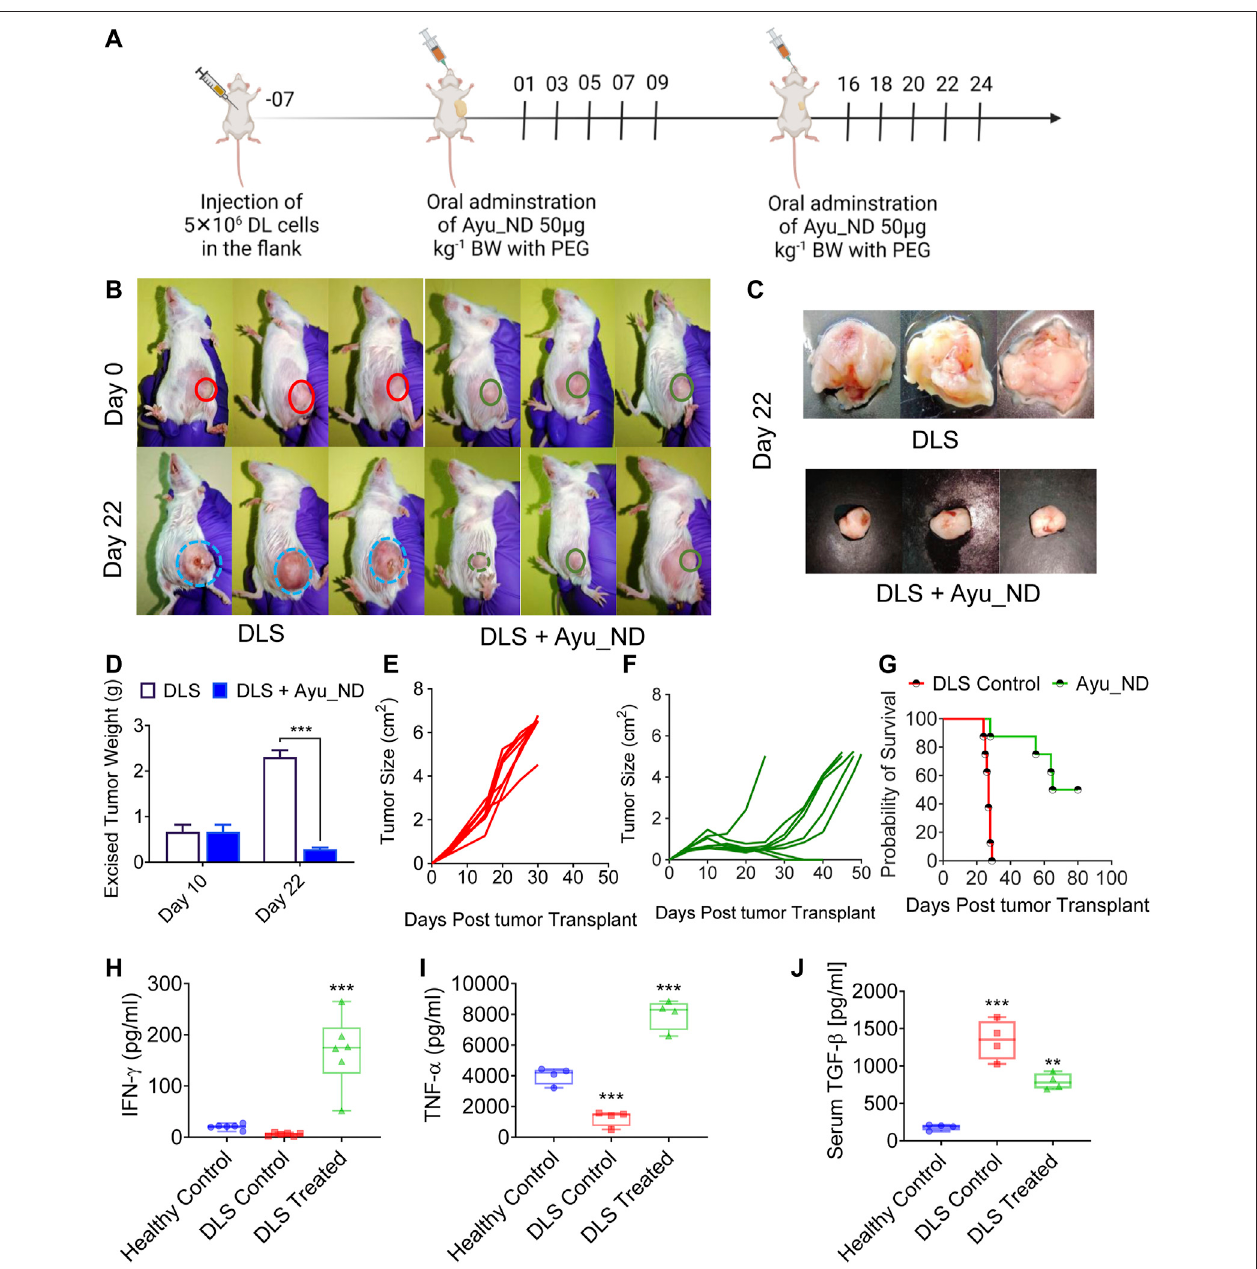
FIGURE5| Ayu_NDtreatmentsuppressesthegrowthofDLsolidtumorsandenhanceslong-termsurvival.Schemeofthetherapeuticprotocolillustratingthetime points ofAyu_NDadministration inDLsolidtumor-bearingCD1mice.Ayu_ND(50 μ g/kg)wasorallyadministered ondays1,3,5,8,7,and9andondays16,18,20,22 and24.Tumorvolumewasmeasuredondays2,4,8,12,16,20,and24andcontinueduntilday50inthetreatedgroup (A) .Onday22,threemicefromeachgroupwere sacri fi ced between 9:00 a.m. and 11:00 a.m. The tumors were obtained. Images of solid DL tumor growth in CD1 mice at day 0 (before treatment) and after 3 weeks (day 22) following treatment with Ayu_ND (B) . Tumor weight comparison between untreated and treated groups performed at day 22 (C , D) . Tumor size in the untreated and Ayu_ND-treated groups showed signi fi cantly reduced tumor volume in the treated group compared with the untreated control at day 22 (E , F) . Kaplan – Meiersurvivalanalysisofthetumor-bearingmicefollowingtheabovementionedtreatmentwithAyu_ND (G) .SerumlevelsofIFN- γ (H) ,TNF- α (I) andTGF- β (J) in Ayu_ND-treated animals compared with untreated animals at day 22. Statistical signi fi cance was analyzed by two-tailed Student ’ s t test (C , D) or by the log-rank (Mantel – Cox) test (E) . NS no signi fi cance; * p < 0.05, ** p < 0.01, *** p < 0.001, and **** p < 0.0001.